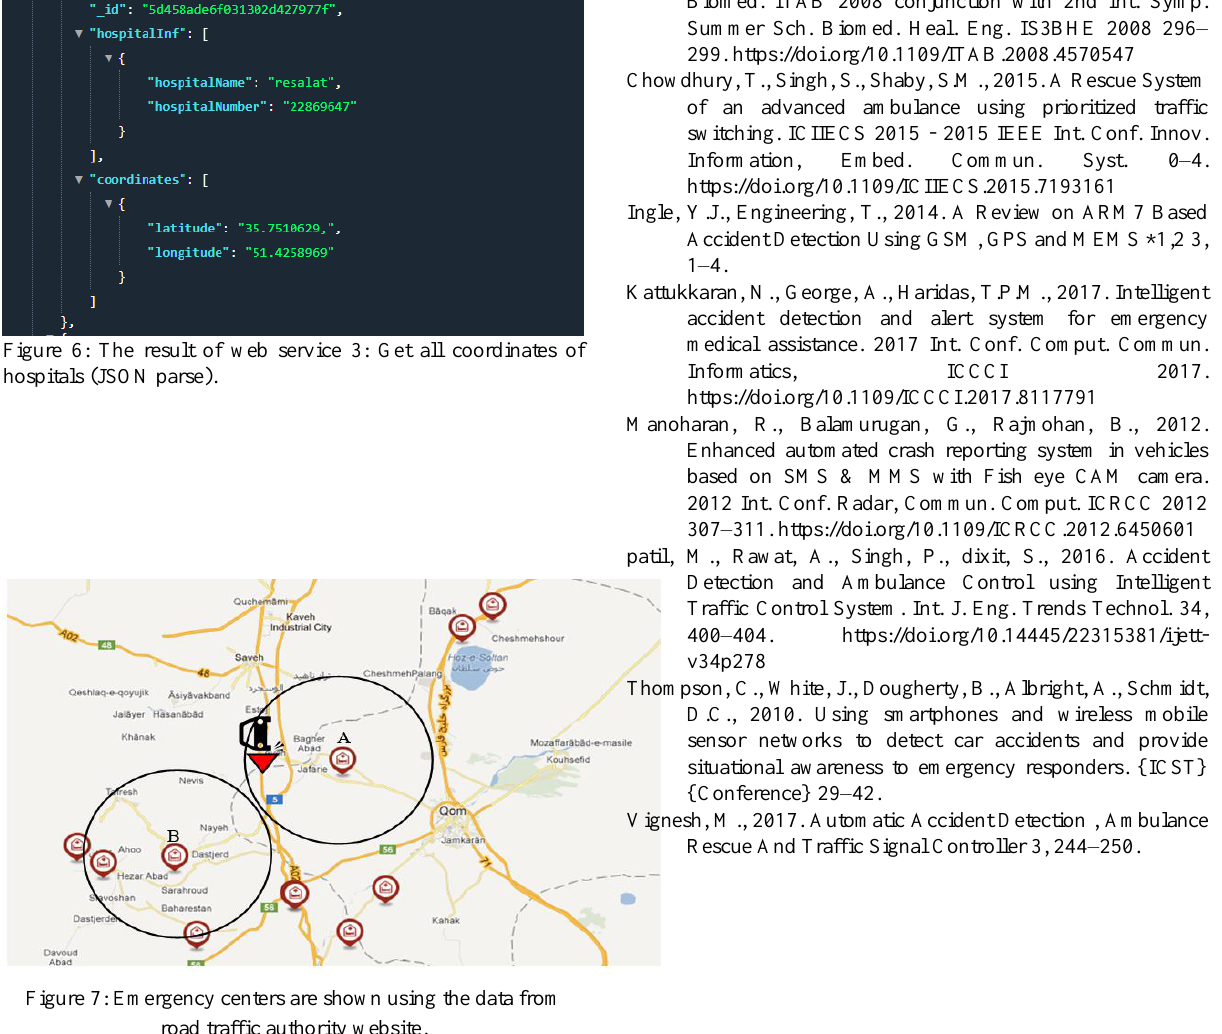
Figure 7: Emergency centers are shown using the data from road traffic authority